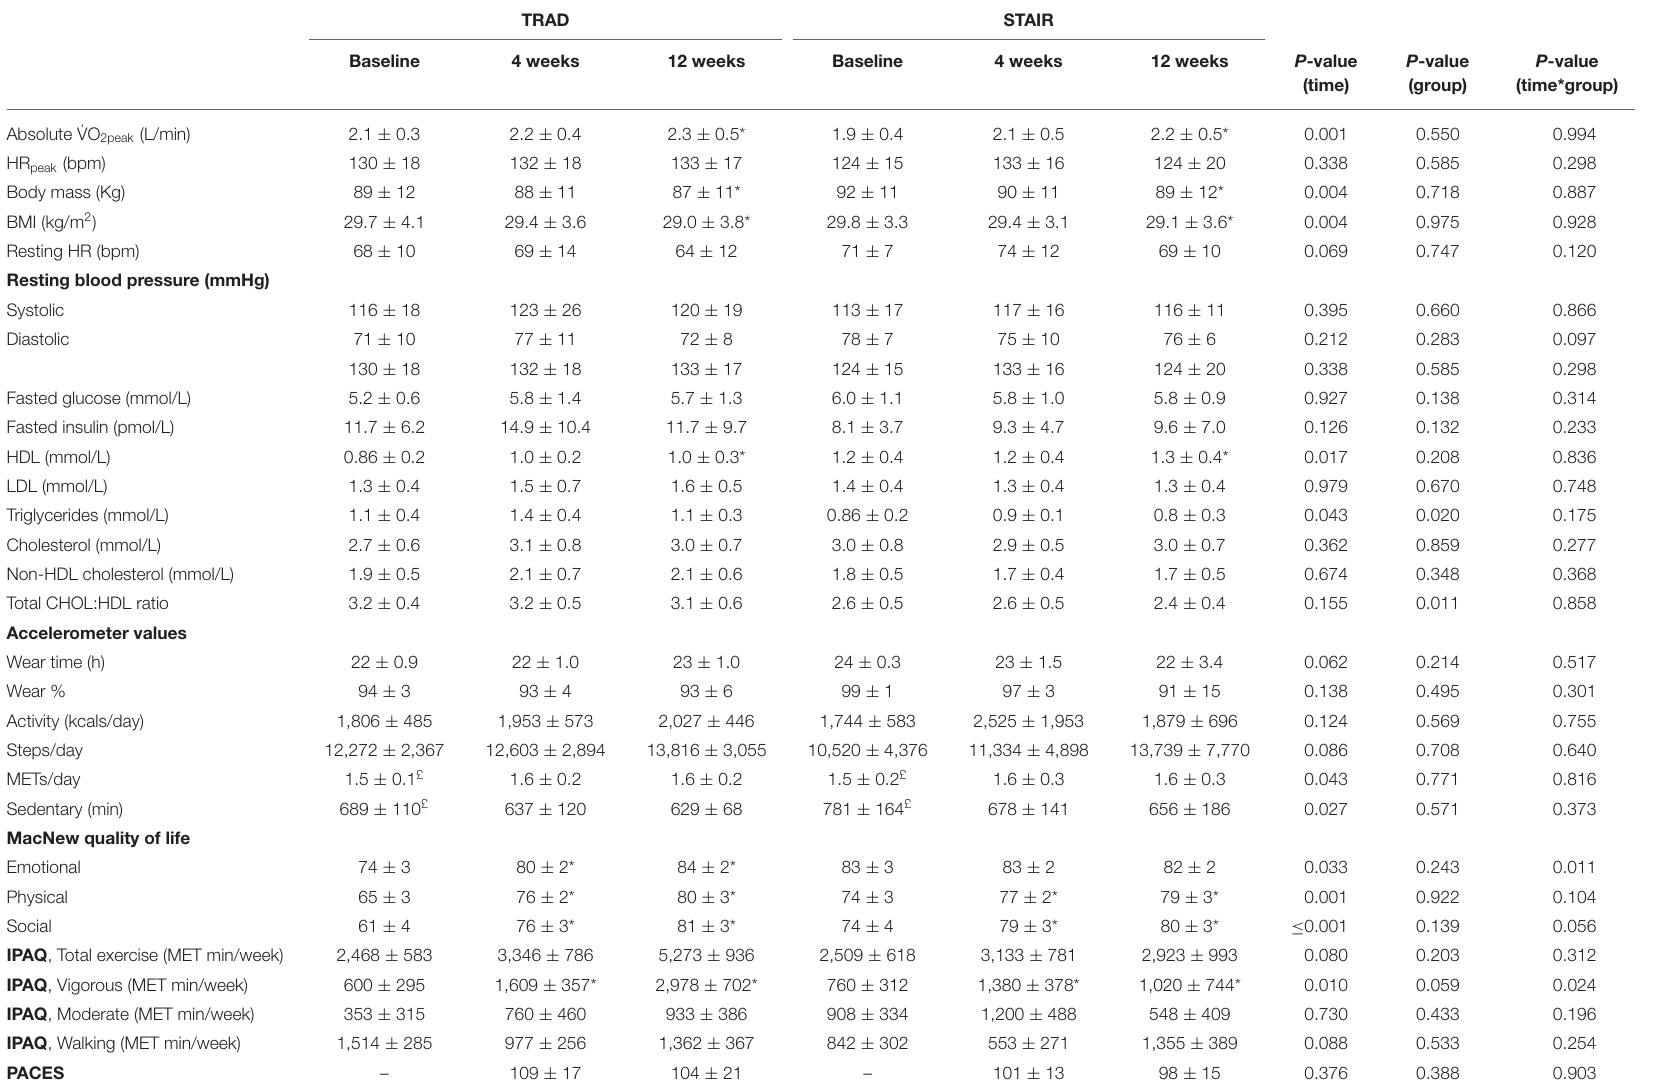
TABLE 3 | Outcomes measures after 4 weeks of 6 supervised sessions and 8 additional weeks of unsupervised exercise training for participants randomized into either traditional cardiac rehabilitation (TRAD, n = 9) or stair climbing-based high-intensity interval exercise (STAIR, n =